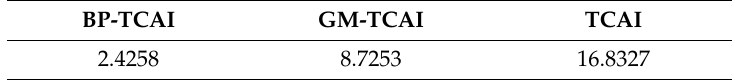
Table 5. Runtime comparisons of BP ‐ TCAI, GM ‐ TCAI and traditional TCAI.